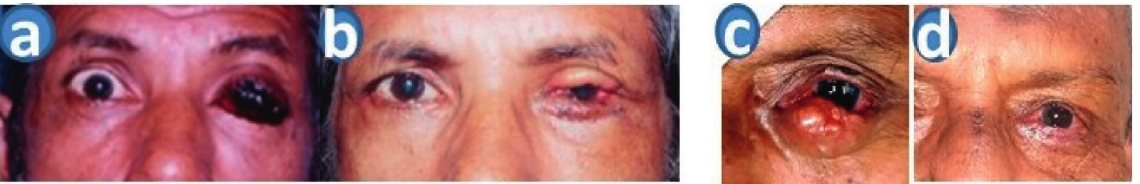
Figure 5: Preoperative and postoperative photographs of eyelid shearing procedures: (a,b) Cutler–Beard procedure and (c,d) Hughes procedure.